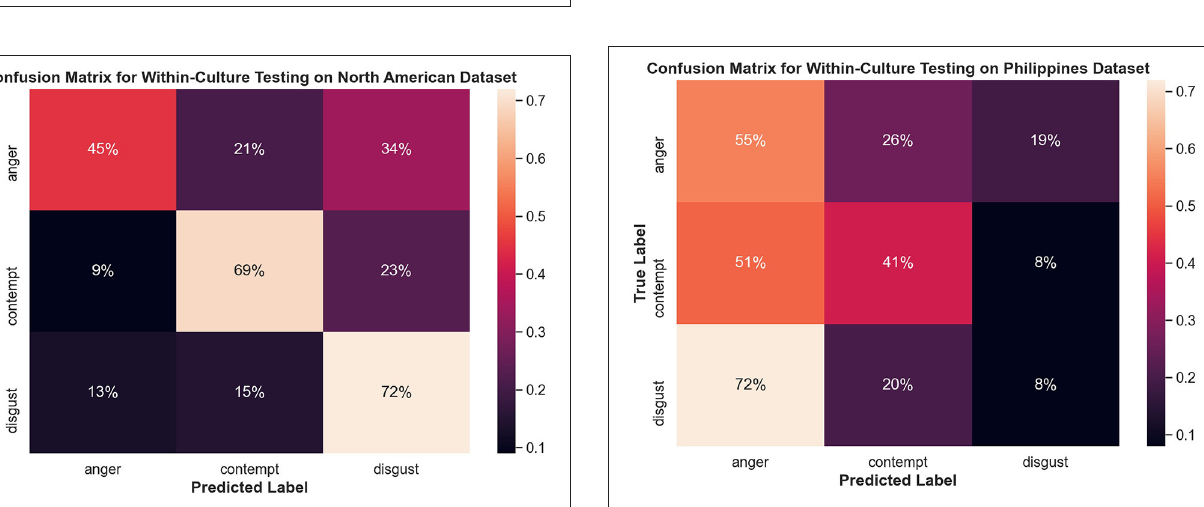
FIGURE 8 | Confusion matrix illustrating the results of all within-culture experiments.